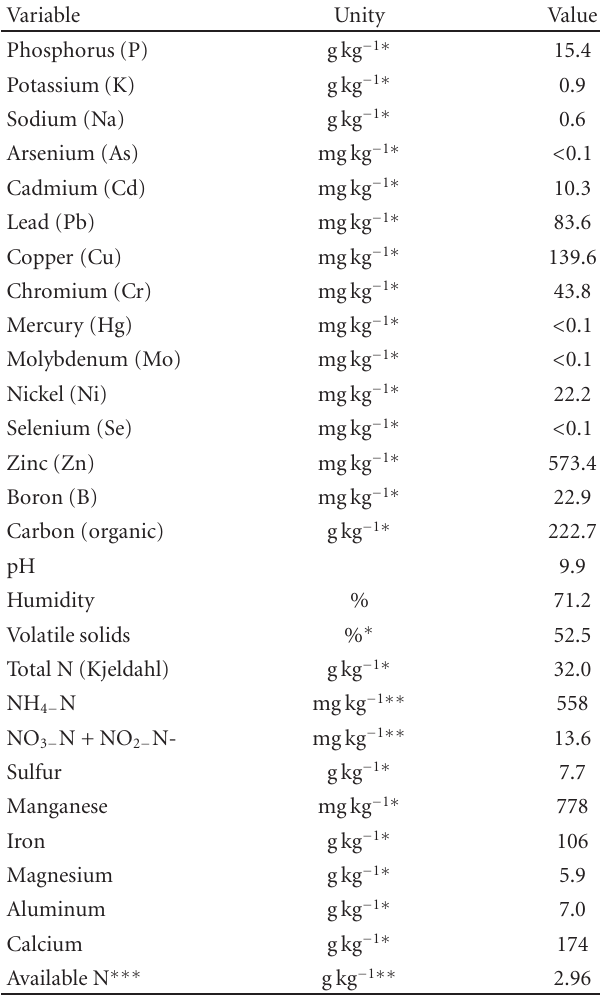
Table 3: Chemical analysis of biosolids used in the experiment (average